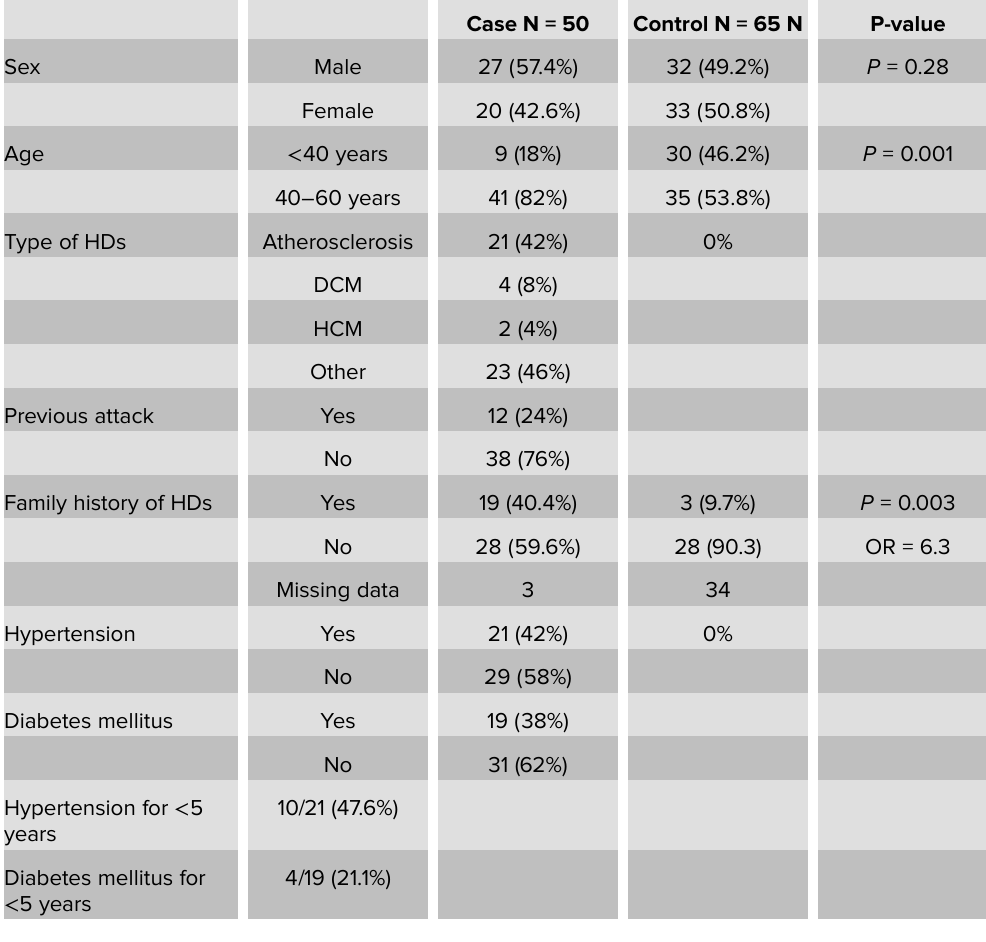
TABLE 2: The demographic data of the HD cases and healthy